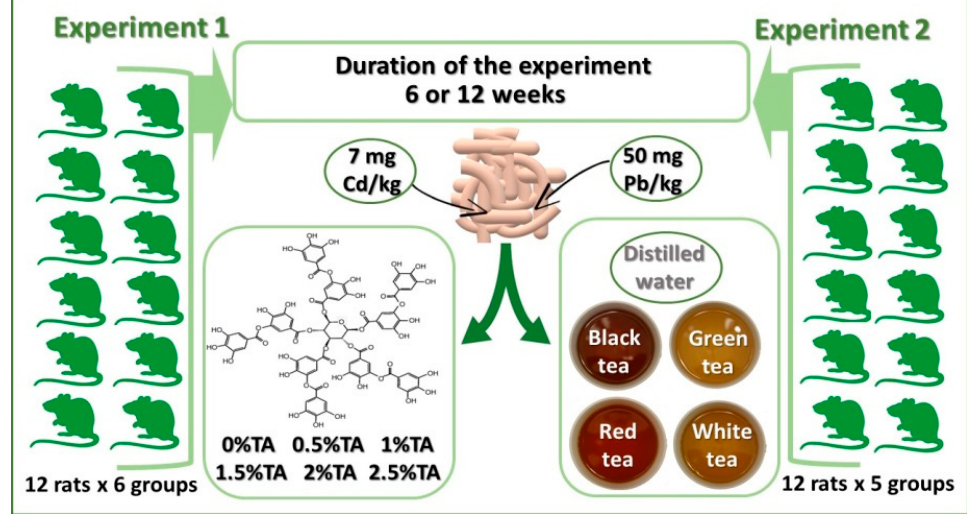
Figure 1. Experimental design. TA—tannic acid.